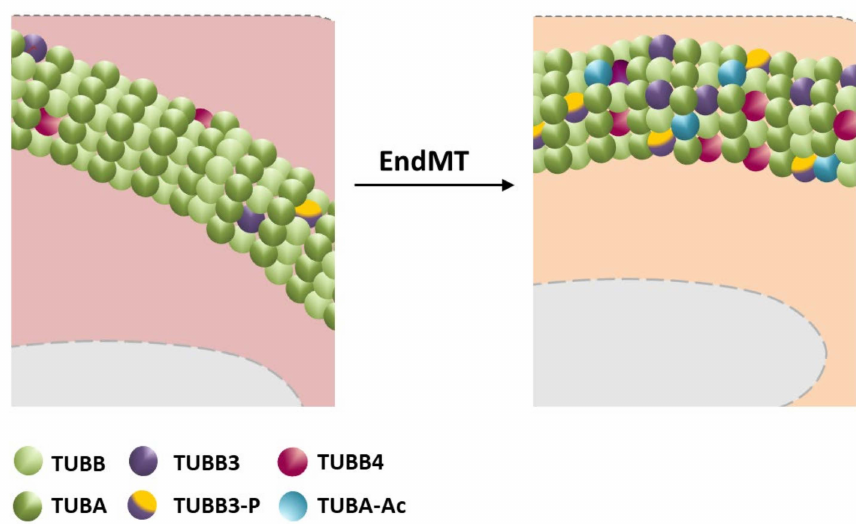
Figure 6. Microtubules reorganization during EndMT. EndMT is accompanied by the upregulation of β 3-tubulin (TUBB3) and β 4-tubulin TUBB4, as well as increased phosphorylation of β 3-tubulin and acetylation of α -tubulin subunits (detailed description in